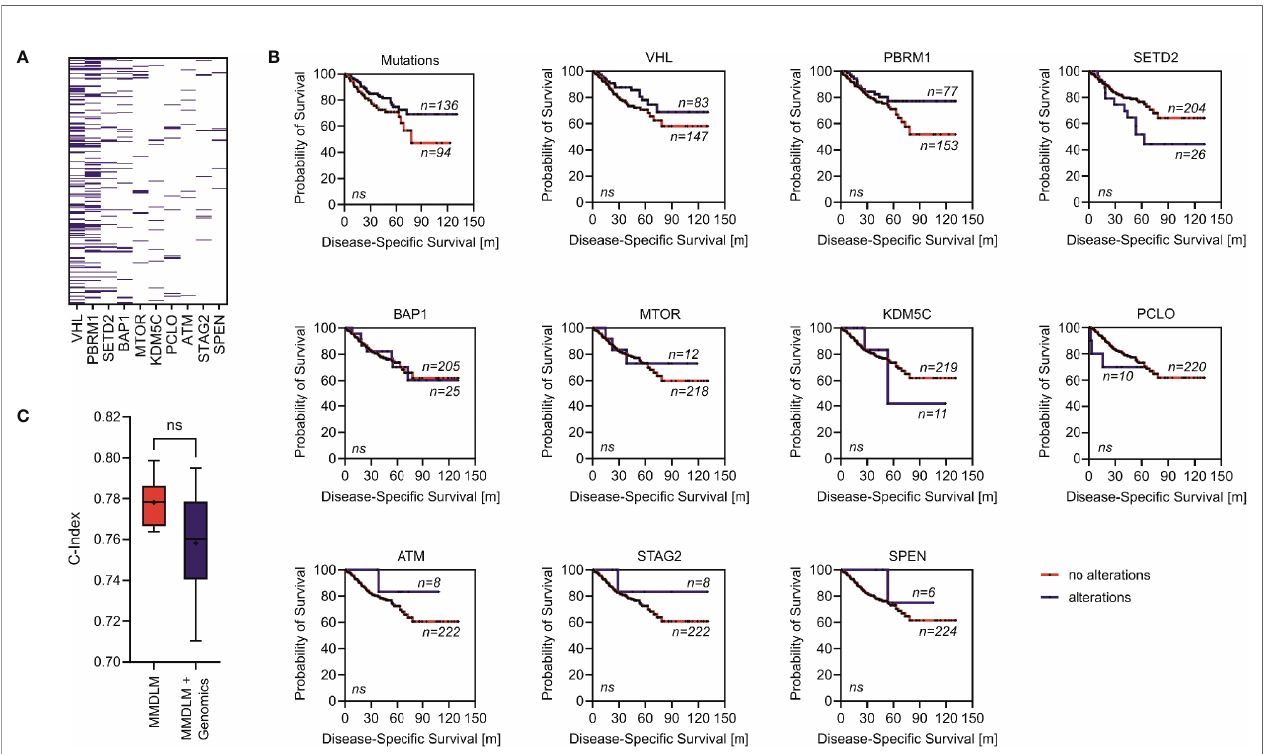
FIGURE 3 | Addition of genomic information does not improve the MMDLM. (A) Distribution of the ten most frequent mutations/CNA in our cohort. (B) Survival strati fi ed according to mutational status (alterations/no alterations) of the genes selected in panel (A) . (C) C-Index distribution using a MMDLM without and with the mutational status included. Ns, not signi fi